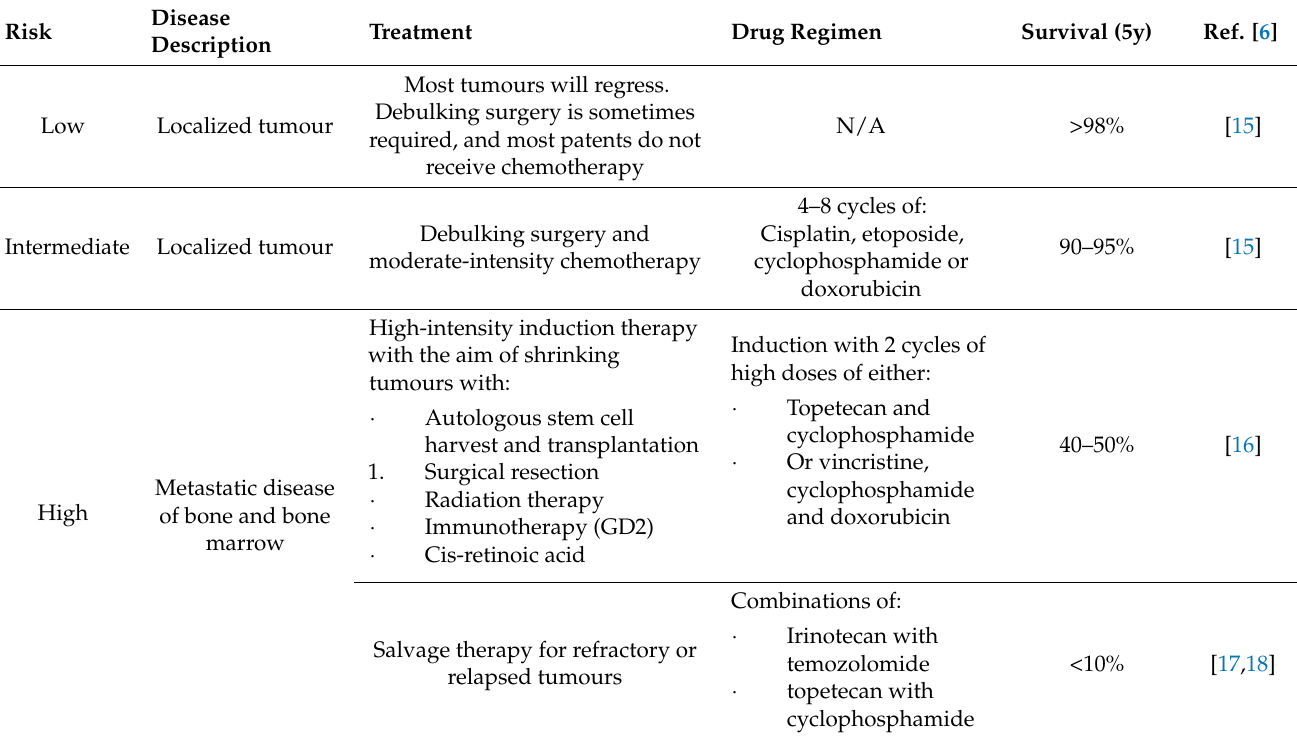
Table 1. Current standard-of-care therapy for neuroblastoma based on the Children’s Oncology Group neuroblastoma risk stratification